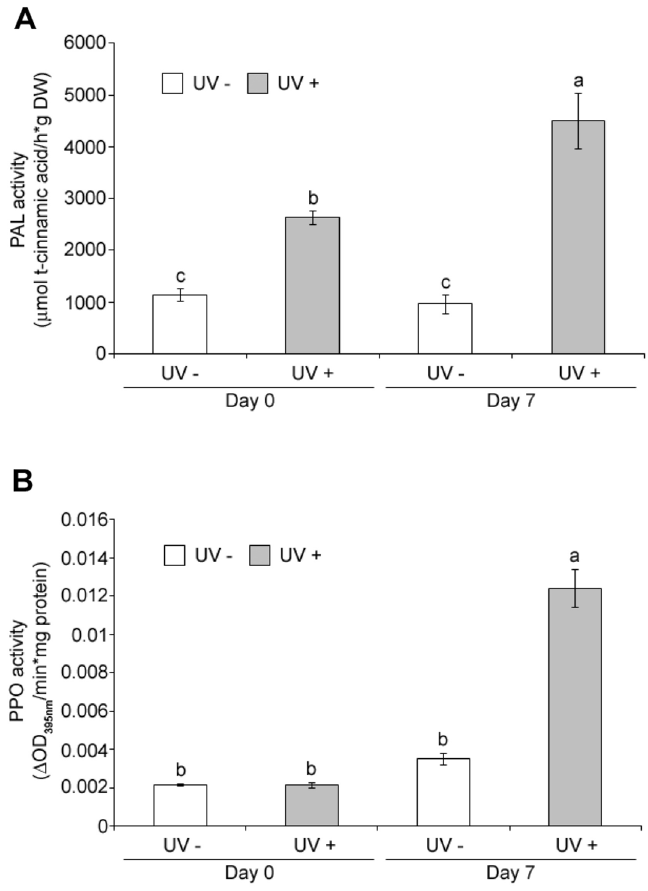
Figure 4. Effect of UVC on phenylalanine ammonia-lyase (PAL) and polyphenol oxidase (PPO) activity. Acerola fruits without (UV−) or with UVC treatment (UV+) were stored at 10 °C for 0 day (Day 0) or 7 days (Day 7) and subjected to the PAL assay ( A ) and the PPO assay ( B ). Data, obtained from at least three biological repeats, are shown as mean ± SE values. Different letters indicate significant differences by the ANOVA/Tukey- HSD ( p <